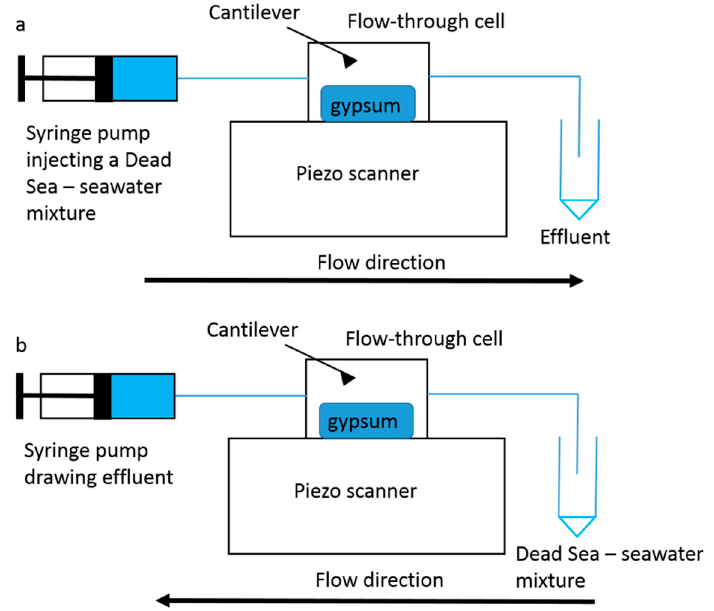
Figure 11. Schematic representation of an in-situ flow-through growth experiment in the AFM. ( a ) Syringe pump injects solution into a flow-through cell thereby increasing the pressure within the cell, which may cause leaks. ( b ) Syringe pump draws the solution into the cell greatly reducing the chance of a leak.